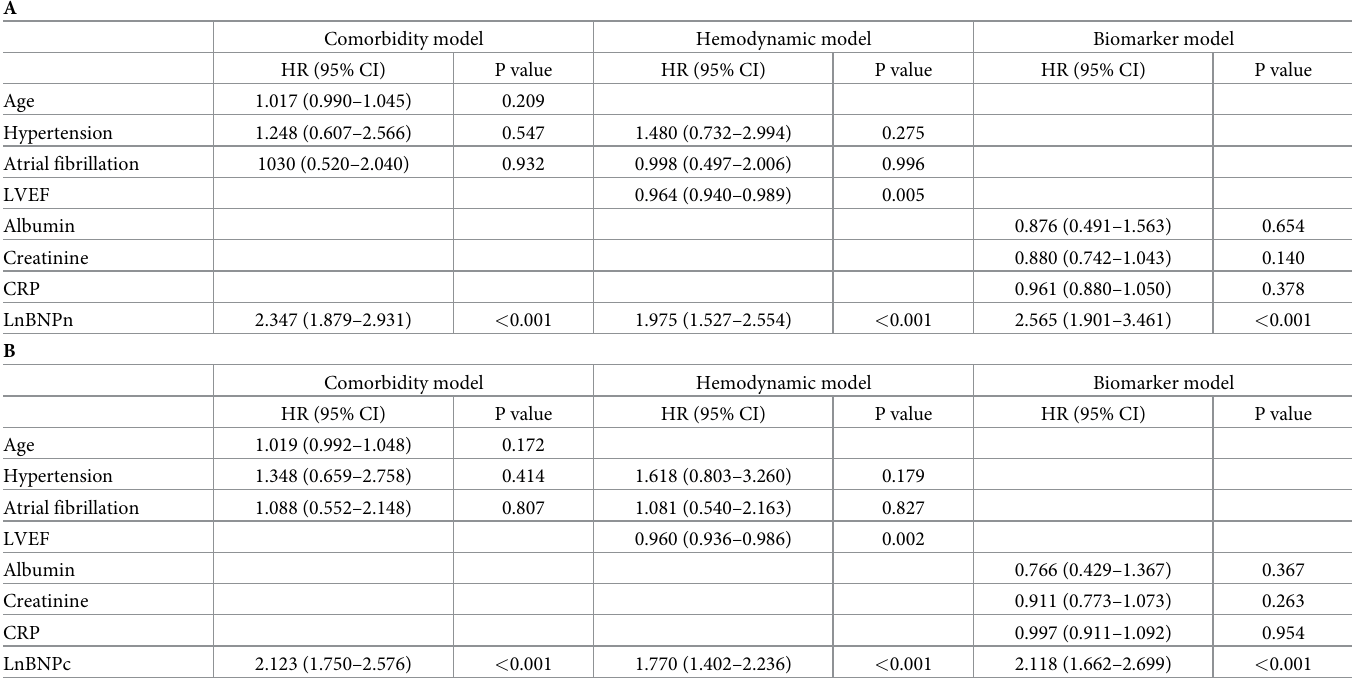
Table 4. A : Multivariable Cox regression analyses of predictors of cardiac events incorporating LnBNPn. B : Multivariable Cox regression analyses of predictors of cardiac events incorporating